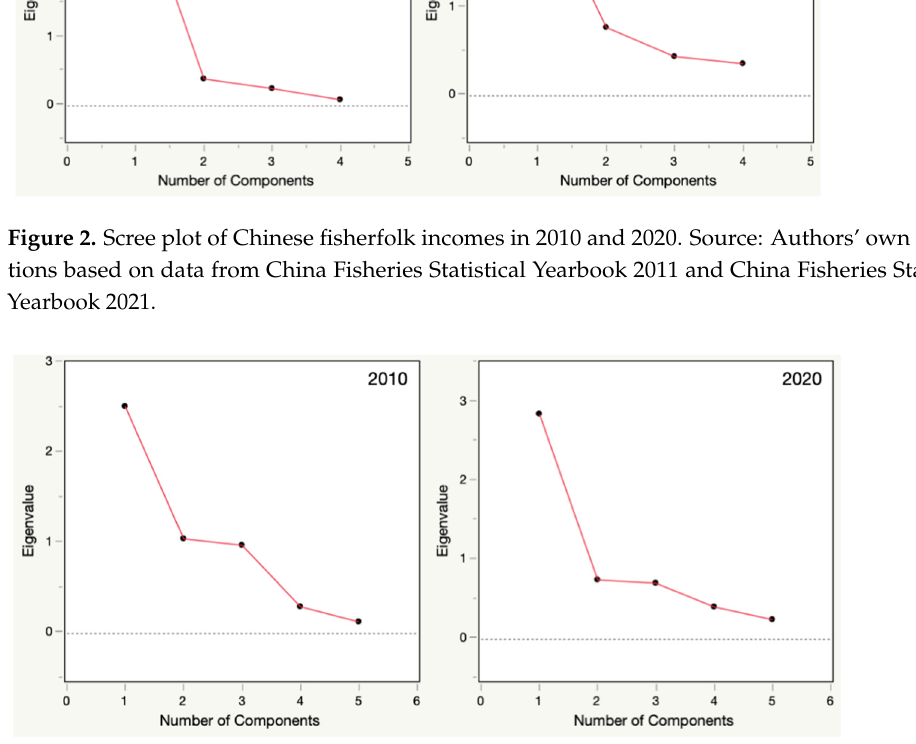
Figure 3. Scree plot of environmental conditions in different Chinese regions in 2010 and 2020. Source: Authors’ own calculations based on data from China Fisheries Statistical Yearbook 2011 and China Fisheries Statistical Yearbook 2021.